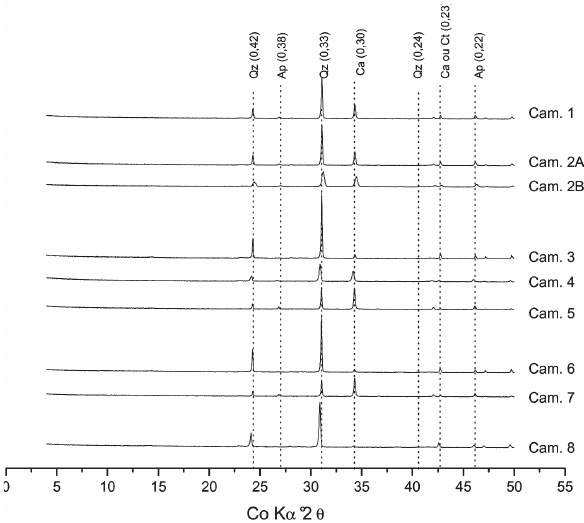
Figura 5. Difratogramas de raios-X da fração silte do solo da Lapa do Malhador. Qz: quartzo; Ct: caulinita; Ca: calcita; Ap: apatita; e Ru: